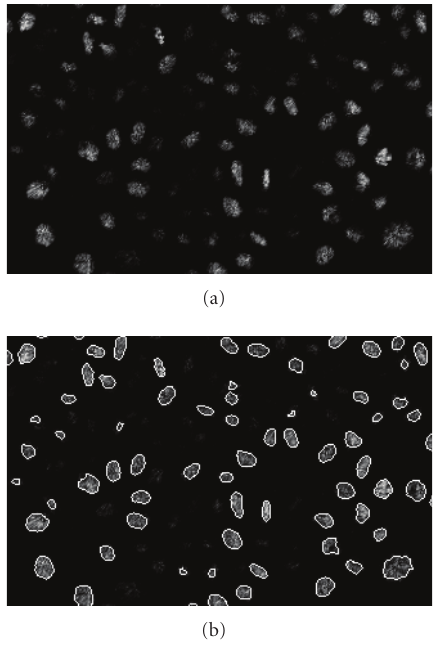
Figure 6: (a) A slice cut of the original data and (b) their overlapping with a cut of the segmented surfaces.